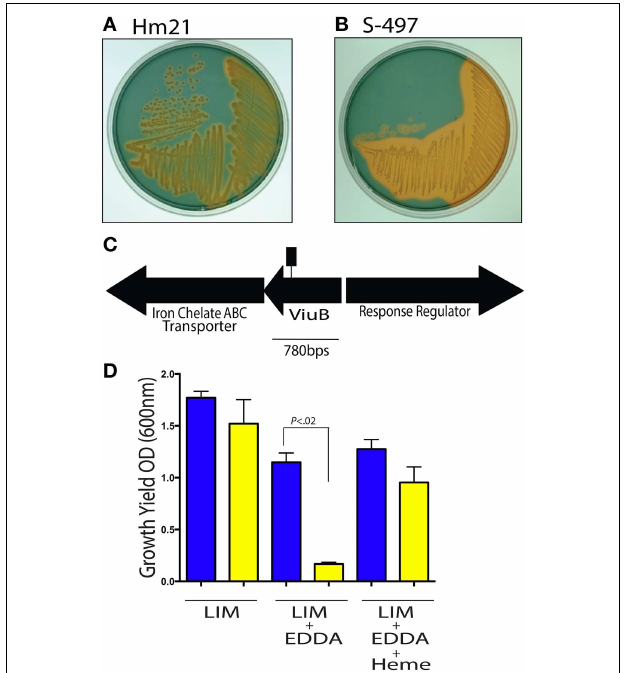
FIGURE 1 | Siderophore activity in A. veronii . The siderophore production of the parent strain Hm21R (A) and the transposon mutant S-497 (B) were assessed using CAS agar. The iron-CAS complex changes color from blue to orange when iron is dissociated from CAS and thus can reveal the production of a siderophore. A portion of the siderophore locus from A. veronii, Hm21, is shown (C) . The transposon insertion site is indicated by the square lollipop (C) . The in vitro LIM growth yield of HM21R (blue) and S-497 (yellow) mutant was determined by measuring the OD 600 24h after inoculation in LIM, LIM (150 µ M EDDA) or LIM (150 µ M EDDA and 50 µ g/ml hemin) (D) . The statistically significant difference between the parent strain and each mutant was performed using the Mann–Whitney test. This revealed HM21 possess a mechanism for utilizing iron from heme containing molecules.